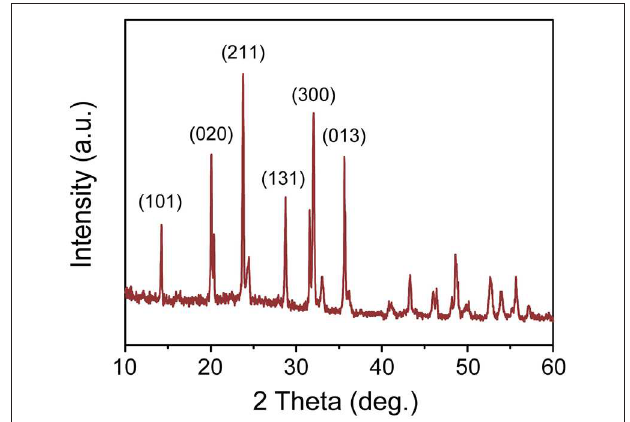
FIGURE 1 | The XRD pattern of NVPF/C/rGO composite.